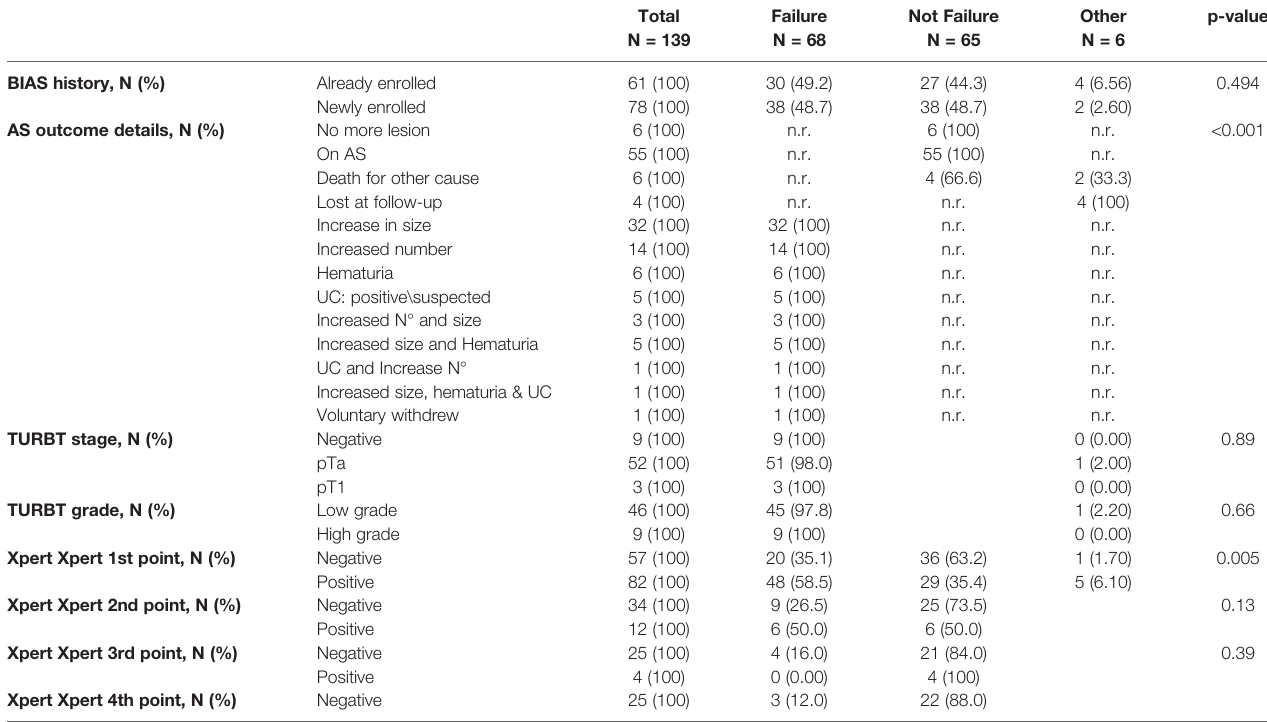
TABLE 2 | BIAS outcome details, pathological features and Xpert test results by active surveillance